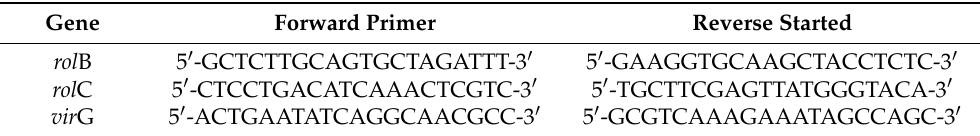
Table 6. Sequences of primers used in the PCR reaction